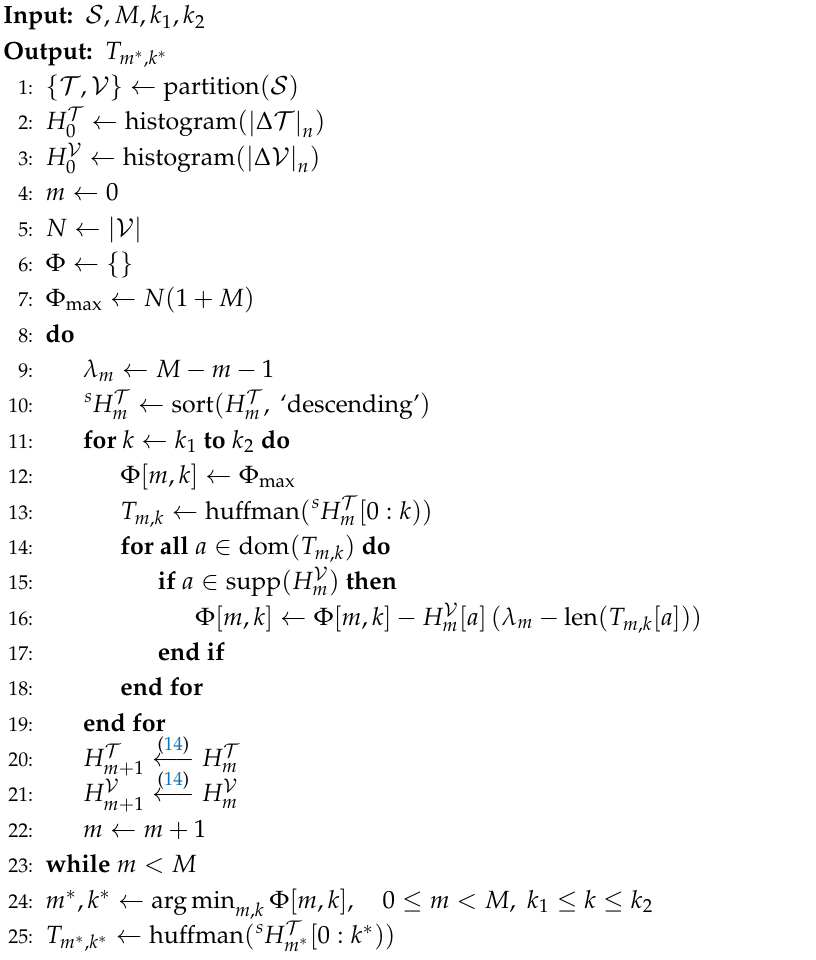
Algorithm 2 Fast hyperparameter optimization and Huffman table